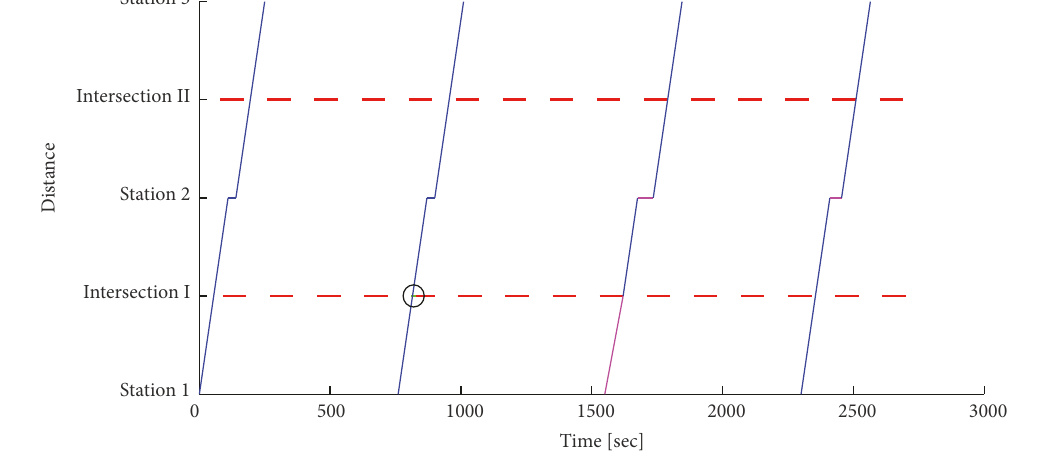
Figure 7: Tram schedule of four trams. Table 6: Performance comparison of GA and